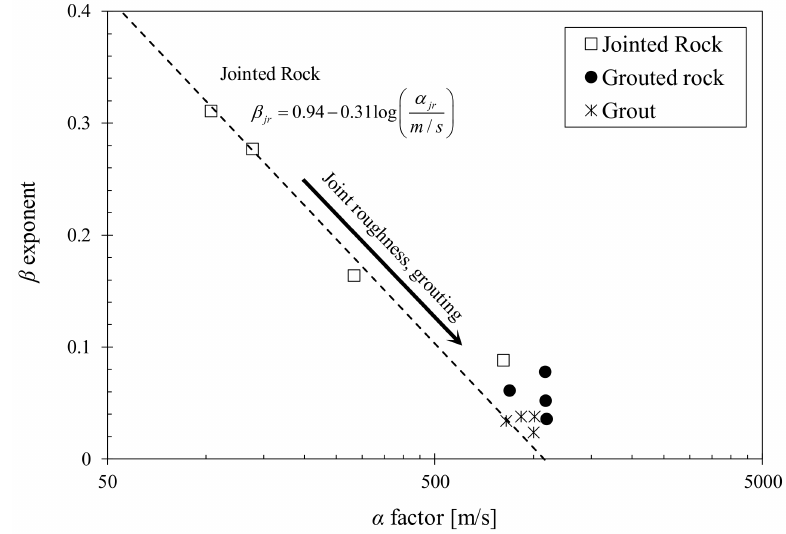
Figure 6. α and β parameters of the Hertzian power function for all tested grout and rock specimens (The trend line for jointed rock specimens is adopted from Cha et al. (2014)